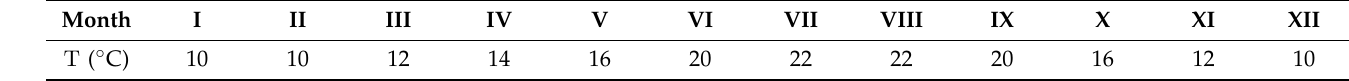
Figure 5. The sequence of pouring the blocks of the odd (light grey) and even (dark grey) monoliths. On all sides of the galleries which are in contact with air, the measured internal air temperatures T ag , sr during construction and service life are applied [44], ranging from 10.0 to 22.0 ◦ C (Table 2). Table 2. Measured mean monthly temperatures of air inside the galleries T ag , sr [ ◦